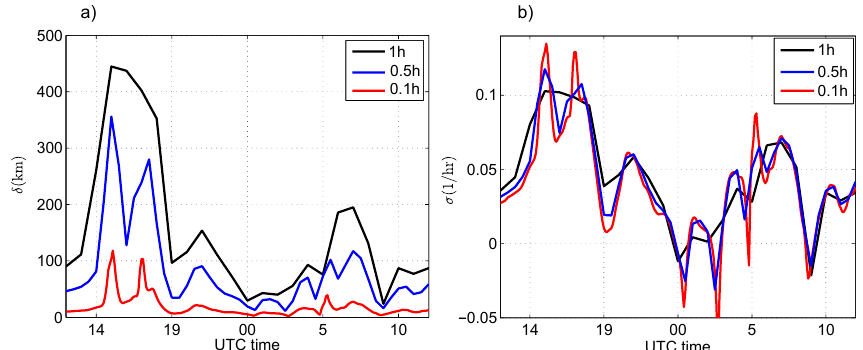
Figure 8. (a) δ as the benchmark (true) distance between successive source points corresponding to δt = 0.1, 0.5 and 1h. The horizontal axis represents the averaged time corresponding to each successive pair. (b) Approximated local FTLE for different δt s from 0.1h (6min) to 1h. The interrogation window is 12:00UTC 29 September to 12:00UTC 30 September